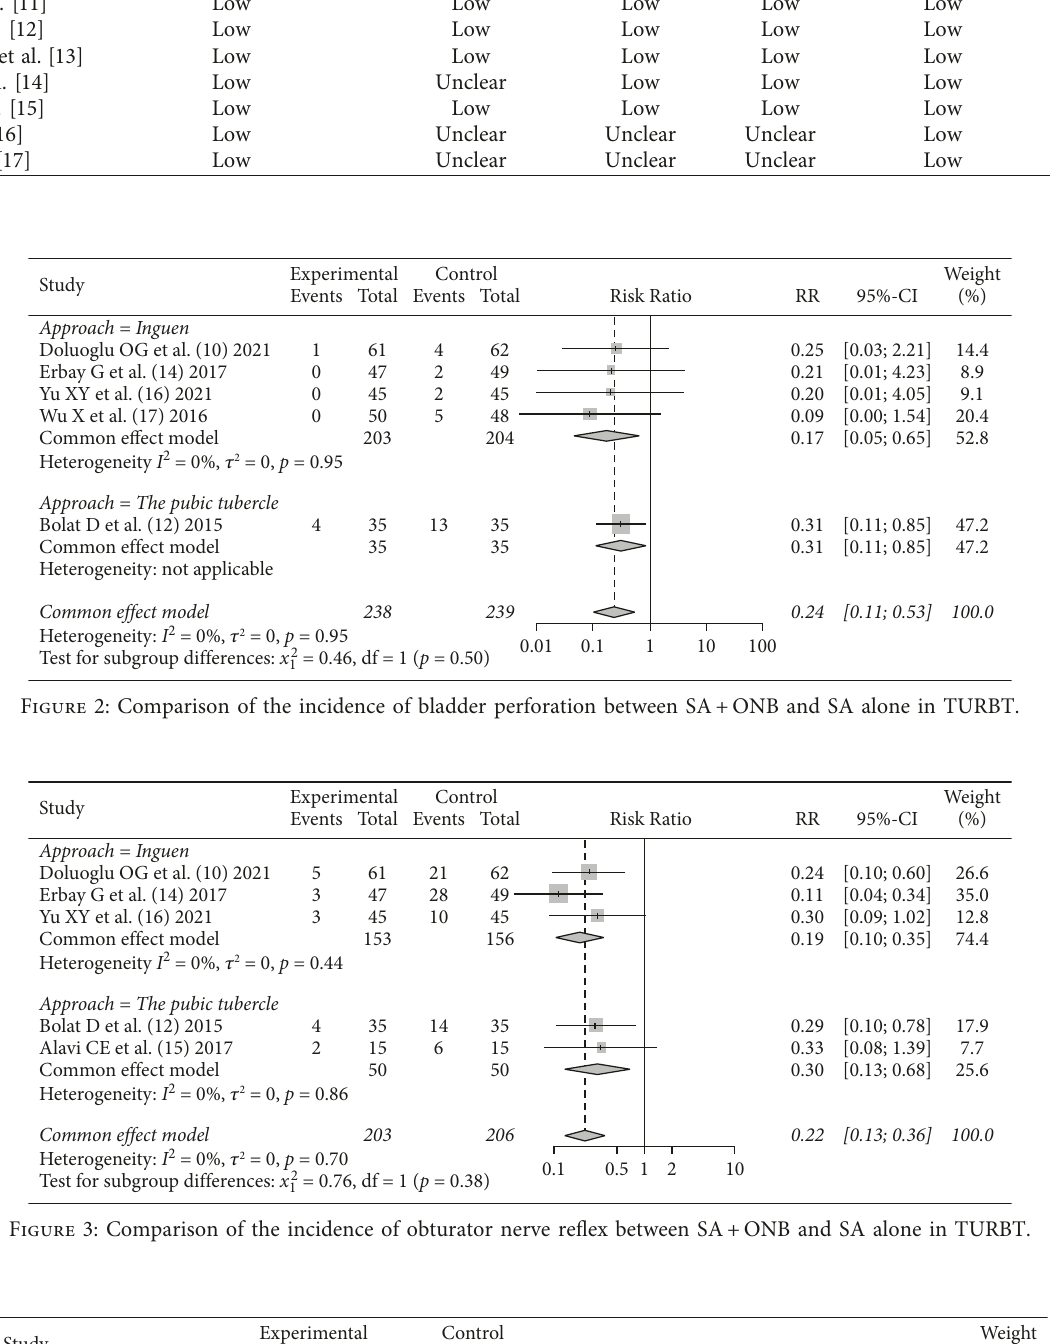
Doluoglu OG et al. (10) 2021 Yu XY et al. (16) 2021 Wu X et al. (17)